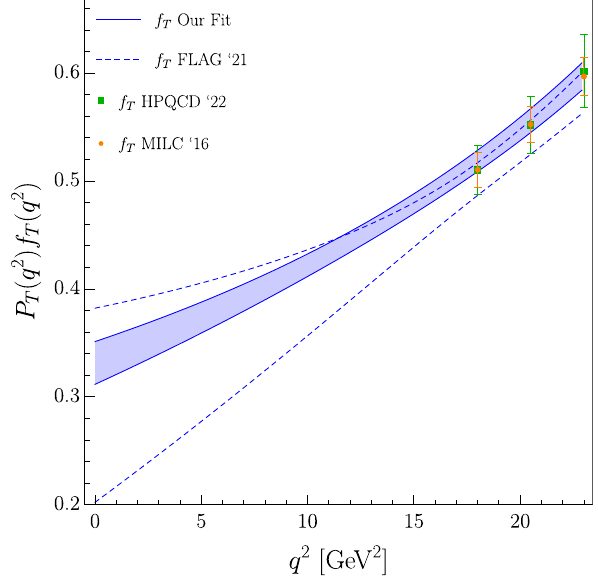
Fig. 7 The result of our fit for the f T ( q 2 ) form factors is depicted by the blue region respectively, compared to the result reported by FLAG [35] and the HPQCD (green points) [33] and FNAL/MILC (orange points) [34] results